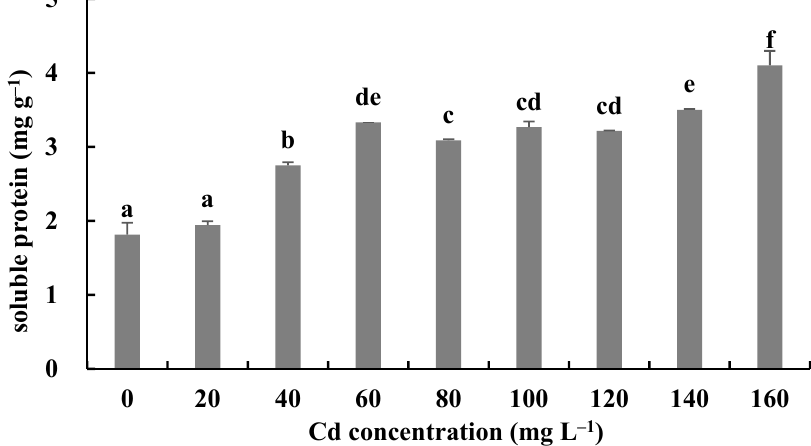
Figure 10. Effects of different concentrations of Cd 2+ on soluble protein of H. chrysospermus. Different letters indicated significant difference ( p < 0.05).